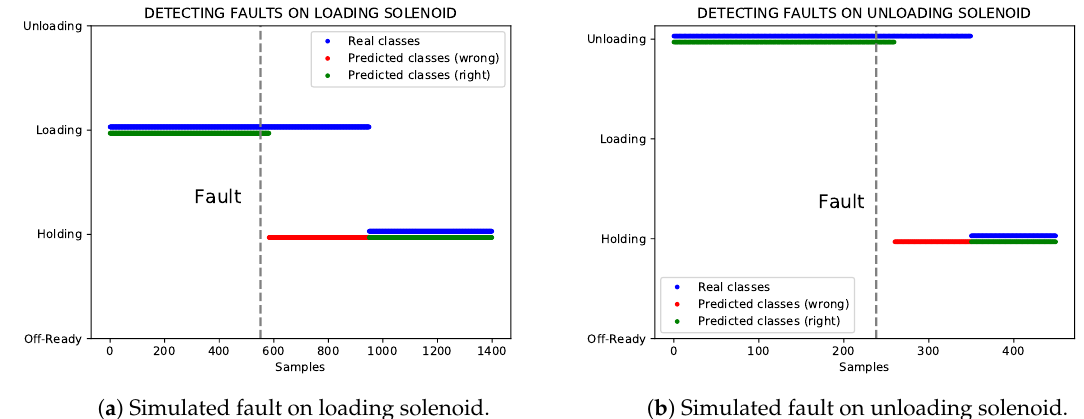
Figure 9. Detecting faults on loading and unloading